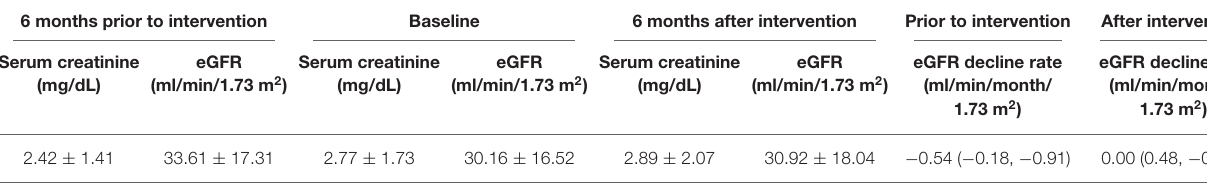
TABLE 2 | Effects of probiotics on the rate of decline of the estimated glomerular filtration rate. 6 months prior to intervention Baseline 6 months after intervention